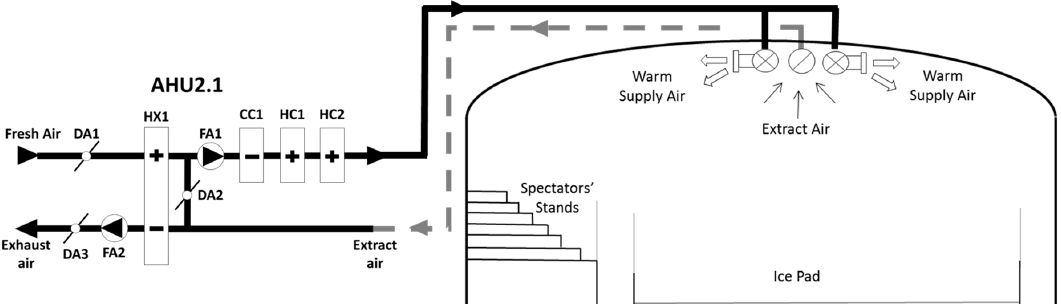
Figure 5. Schematic view of AHU2.1 and its corresponding air distribution system.